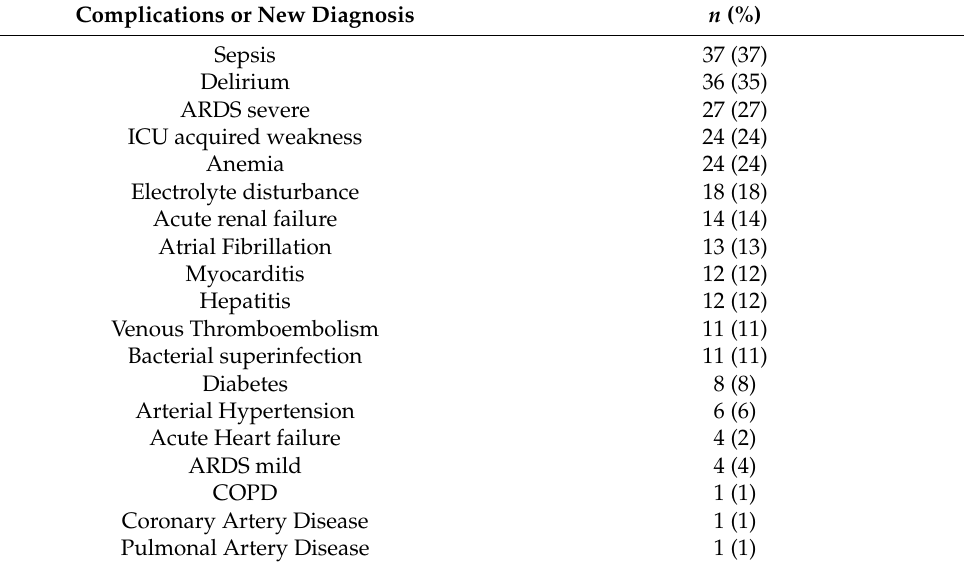
Table 4. Complications due to COVID-19 infection or new diagnosis made during inpatient